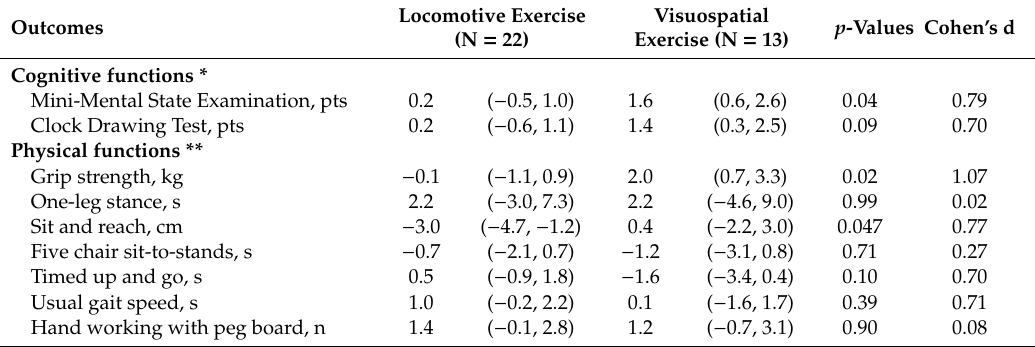
Table 2. Changes in cognitive and physical functions following 12-week locomotive (control arm) or visuospatial (intervention arm) exercise